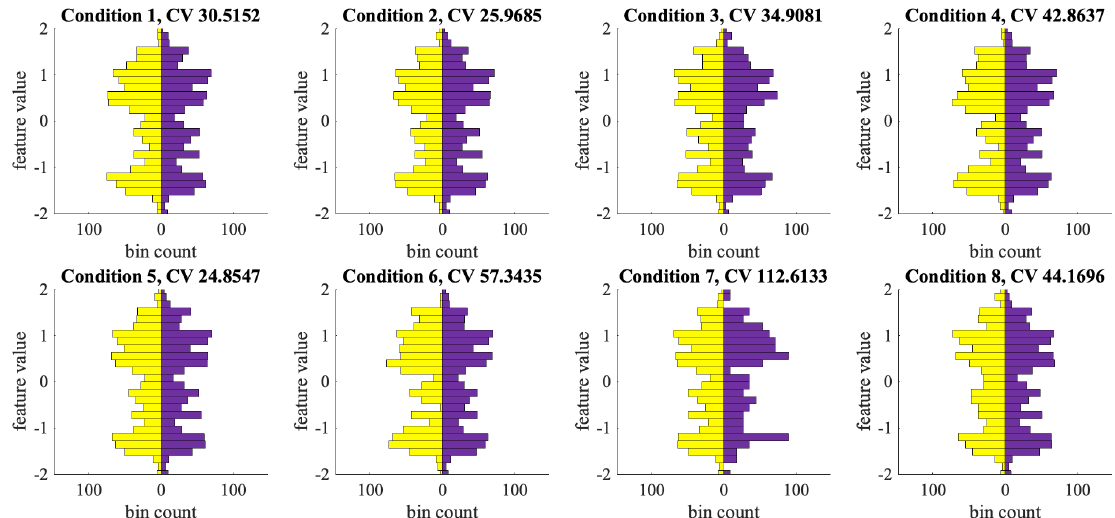
Figure 13. Histogram pairs of the most significant features under eight conditions. With less CV value (weaker statistical significance), the distribution pair would be more